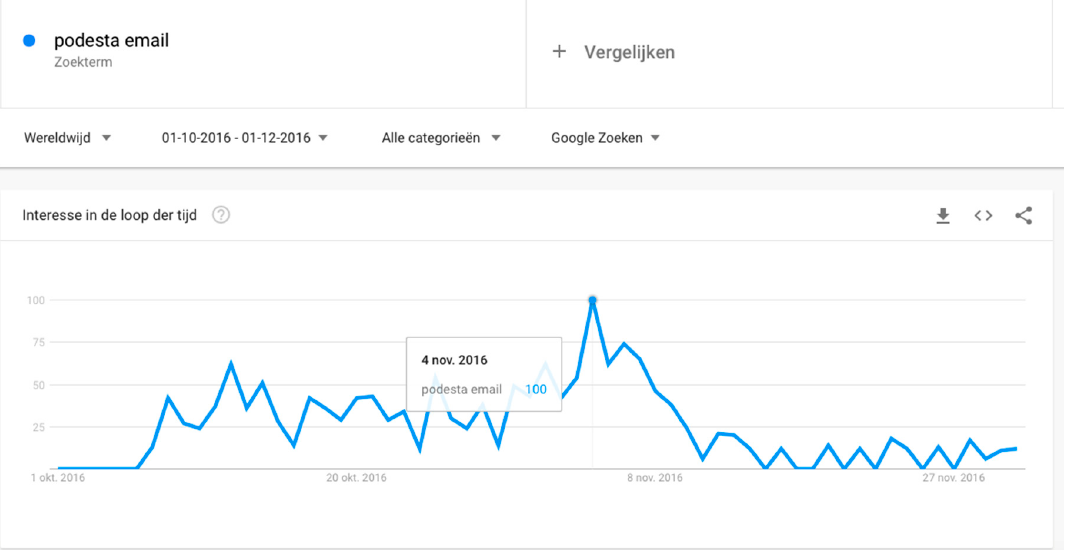
Figure 4. Google Trends—Podesta Email Searches Wordwide.